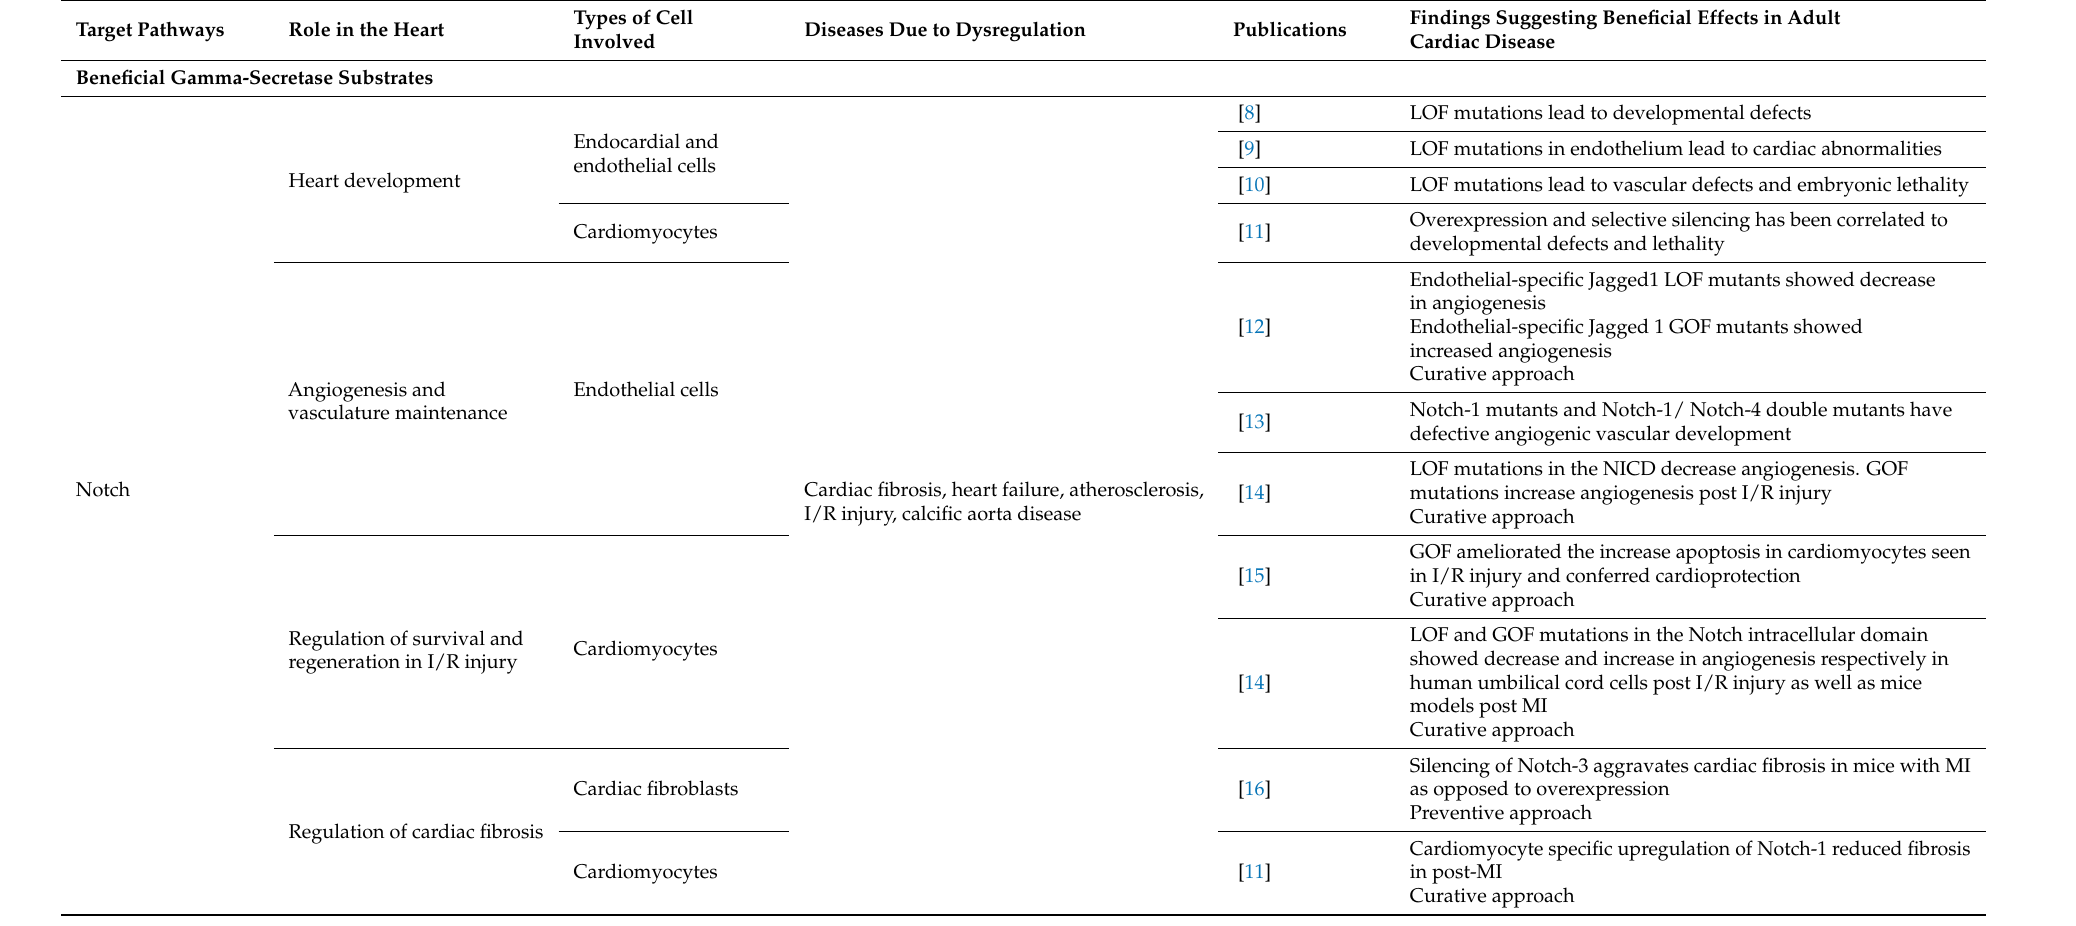
Table 1. Summary of cardiac pathways that are subject to gamma-secretase direct regulation. The table summarizes the major findings from the literature that include gamma-secretase substrates, the cells they are expressed in and the diseases that substrate dysregulation has been linked to. The table also includes the potential beneficial effects of the substrates in the realm of cardiac disease as reported by the literature. We also indicate whether the experimental design suggests a preventive or curative approach for that particular disease. ROS—reactive oxygen species, LOF—loss of function, GOF—gain of